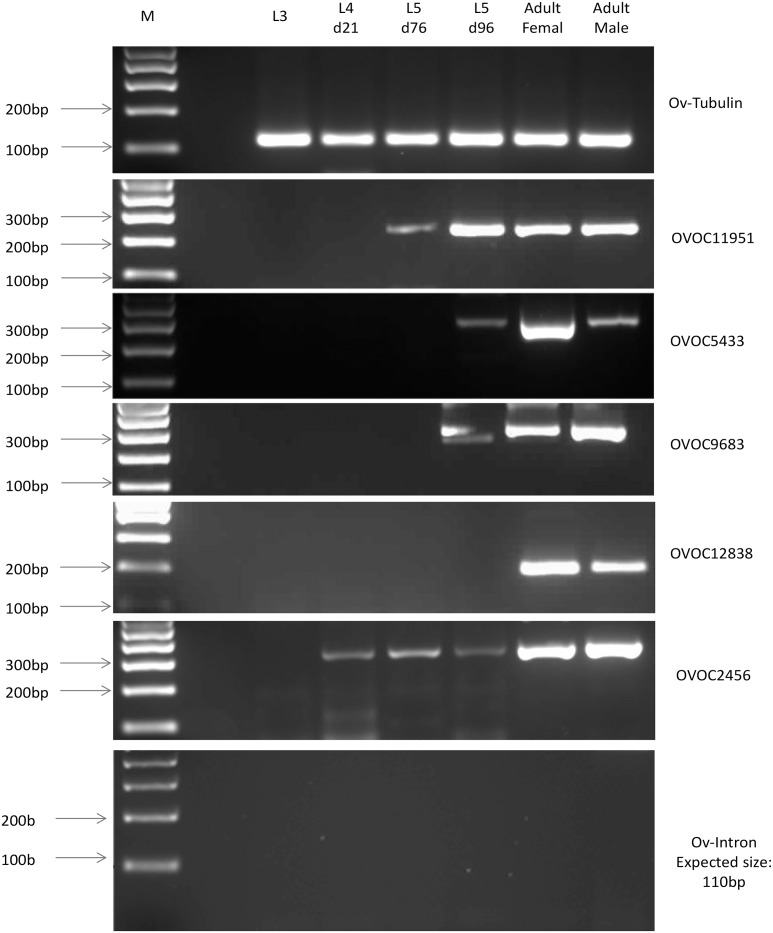
Gel electrophoresis of PCR products obtained using cDNA prepared from L3, L4 D21, L5 D76, L5 D96, adult males and females, and primers corresponding to selected stage-specific biomarkers (S1 Table).Tubulin was used as quality control for cDNA and PCR. Primers for an intron (expected product size– 110 bp) were used as a negative control to test that there was no contamination of genomic DNA. M—Marker.